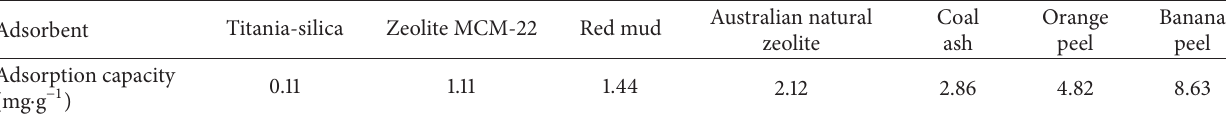
Table 1: Adsorption capacity of RhB onto natural materials.